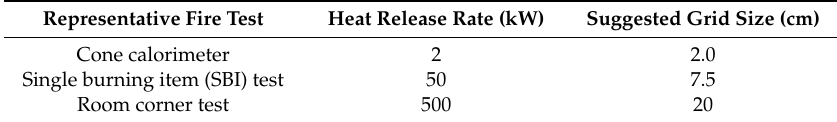
Table 6. Suggested grid size for representative fire experiments proposed in VTT working papers